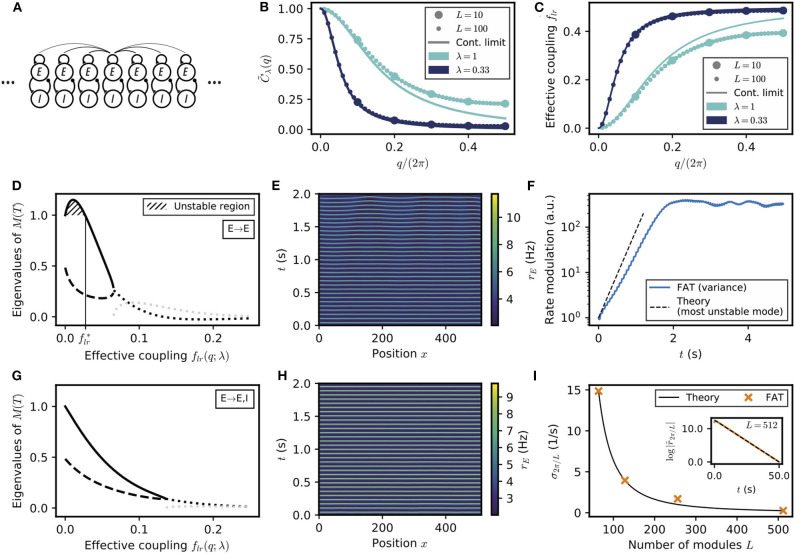
Spontaneous appearance of phase gradients in a chain of E–I modules. (A) Sketch of the chain of E–I modules coupled by long-range excitation. Excitatory neurons in one module target excitatory neurons (E → E) or excitatory and inhibitory neurons (E → E, I) in the other modules with a distance-dependent excitation profile. (B) Fourier transform of the coupling function C~λ(q) (Equation (106)) for perturbations of wavenumber q when the long-range excitation has an exponential profile (Equation 20), for space decay constants λ = 1 (turquoise) and λ = 0.33 (dark blue). For λ ≪ 1, the chain of modules can be approximated by a continuous system. (C) Effective long-range coupling flr(q;λ)=(1-C~λ(q))/2 for perturbations of wavenumber q. (D) Stability spectrum for perturbations of wavelength q as function of the effective coupling flr(q; λ) for E → E connectivity. For small coupling strengths, i.e., long wavelengths, the largest eigenvalue (thick solid line) is larger than 1, and the perturbations are unstable (flr<flr*, hatched region). While both eigenvalues are real and positive for small coupling strengths, they become complex conjugated for larger couplings (real part, thick dotted black line; imaginary part, thick dotted gray line). (E) Excitatory activity rE for a chain of deterministic E–I modules over time (L = 512, with 0.1 mV noise on initial condition). (F) Growth of the variance of excitatory activity ∑n=1L(rn,E-∑m=1Lrm,E/L)2 over time, with the predicted rate for the fastest-growing mode shown on top (dashed black line). (G,H) Same as (D,E) but for E → E, I connectivity. Note that all modes are stable (G) and no instability develops over time (H). (I) Rate of decay of longest wavelength perturbation σ2π/L for different chain lengths L (orange crosses) against the theoretical prediction (Equation (23), black line). Inset: Decay of the spatial modulation of excitatory activity over time (L = 512). For all simulations shown, λ = 1/3.